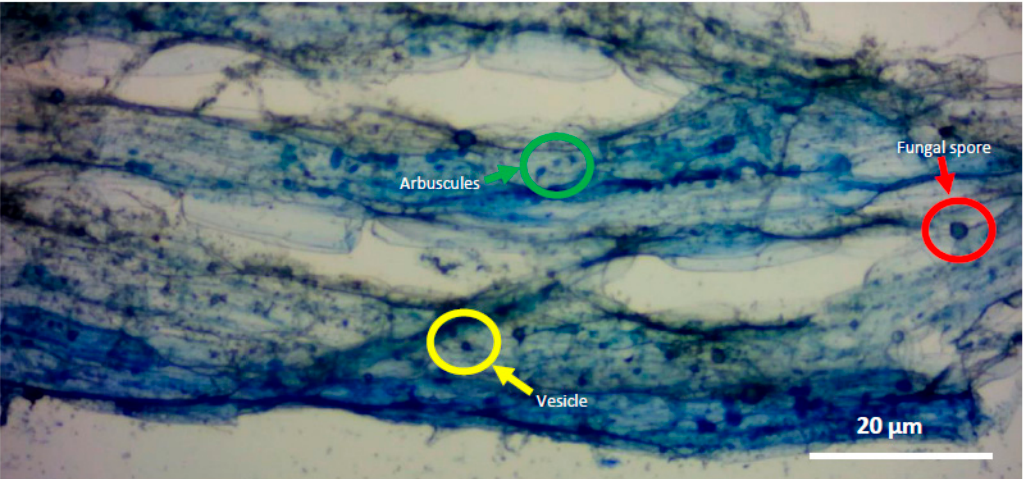
Figure 5. Winter wheat root sections (1 cm length) grown in ZT soil under controlled glasshouse conditions stained with Sheaffer ® blue at 20 weeks post germination. Stained structures are indicated in coloured circles. Images were recorded using a Bresser ® (Rhede, Germany) HD microscope camera under a total magnification of × 100 of an Apex ® (Chippenham, Wiltshire, UK) compound microscope. Mean ergosterol in the ZT soils was consistently greater in the ZTC sampling area